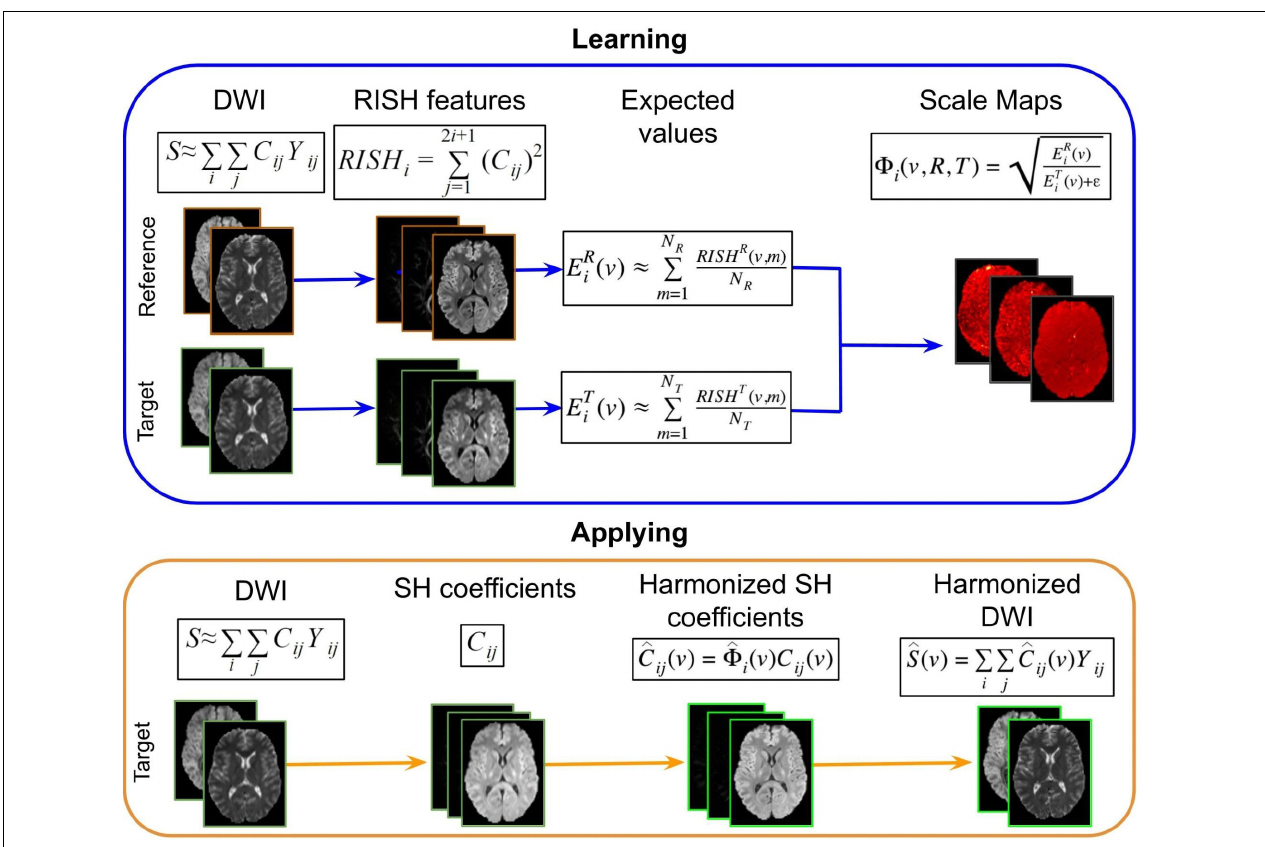
FIGURE 3 | Representation of the RISH harmonization approach. Consider the purpose of modifying the DWI acquired in a target site, to correspond to the DWI acquired in the reference site. In the learning part using matched subjects, the RISH features are computed in native space from the DWI for the two data sets separately: reference ( R ) and target ( T ) sites. Then RISH features are transformed to a common space, the expected values are calculated per site s and per harmonic order i ( E s i ), after which the scale maps are calculated ( (cid:56) i ). The scale maps, which are computed for each harmonic order i , represent the transformation of the RISH features from target to reference site. Next, in the application step, the SH coefficients from the target site are calculated, the scale maps are warped into native space and applied to the SH coefficients, creating harmonized SH coefficients in native space. Those are transformed back to the signal intensity domain, obtaining the harmonized DWI. Thus, harmonized DWI from the target site can be jointly analyzed with the ones from the reference